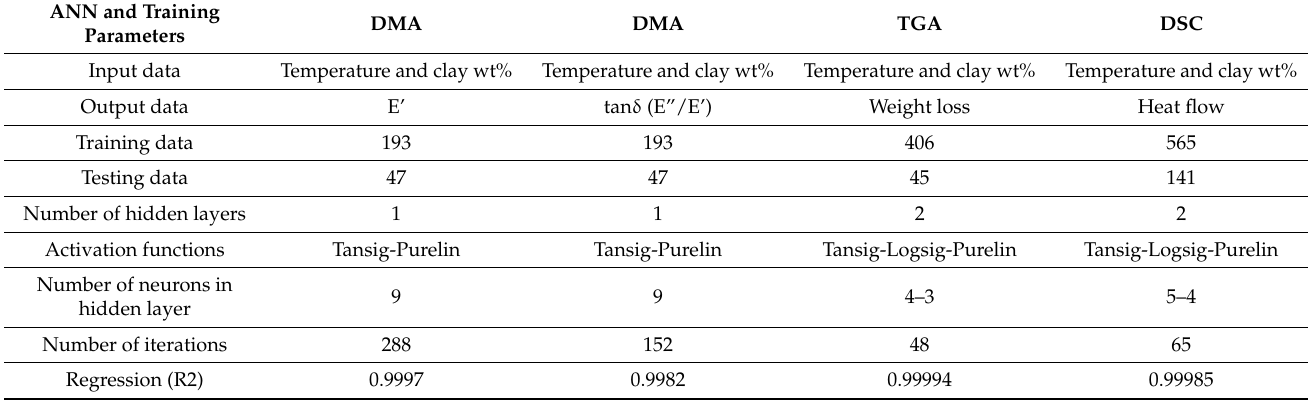
Table 2. Details of the neural network models for prediction of various thermal signals for poly(ethylene oxide)/clay nanocomposites [82]. Reprinted with permission from